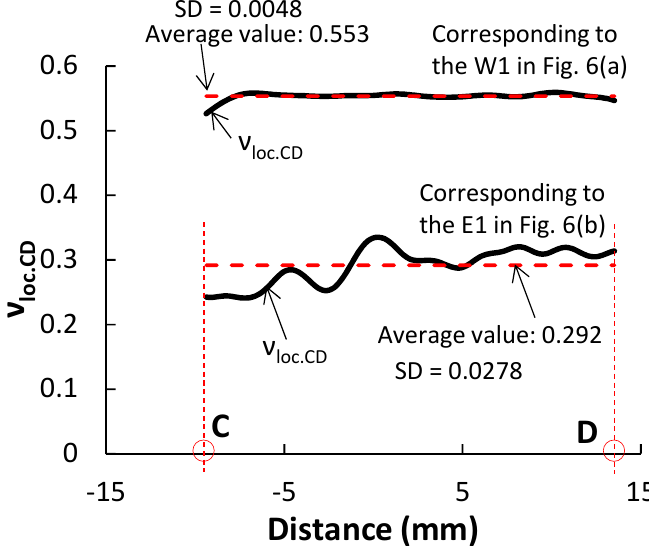
Figure 8. The distribution of the local Poisson’s ratio ( ν loc.CD ) along the CD line corresponding to point W1 and point E1 in Figure 6. SD, standard deviation.